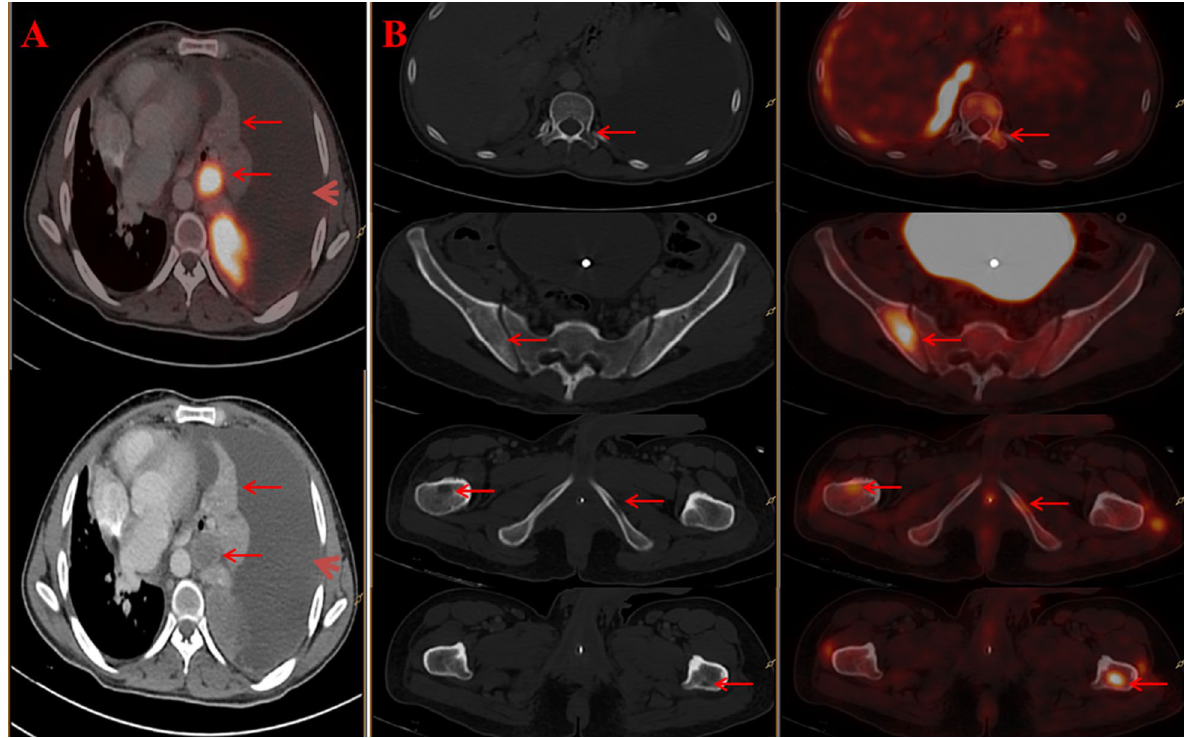
Fig. 2 PET/CT and corresponding CT images A showing metabolically active left hilar lymph node, left pleural effusion (arrow head) and left atelectatic lung. CT and corresponding PET/CT B showing FDG avid multiple lytic skeletal lesions (left transverse possess of D12 vertebra, right iliac bone, right femoral neck region, left ischiopubic ramus and left femoral neck region,